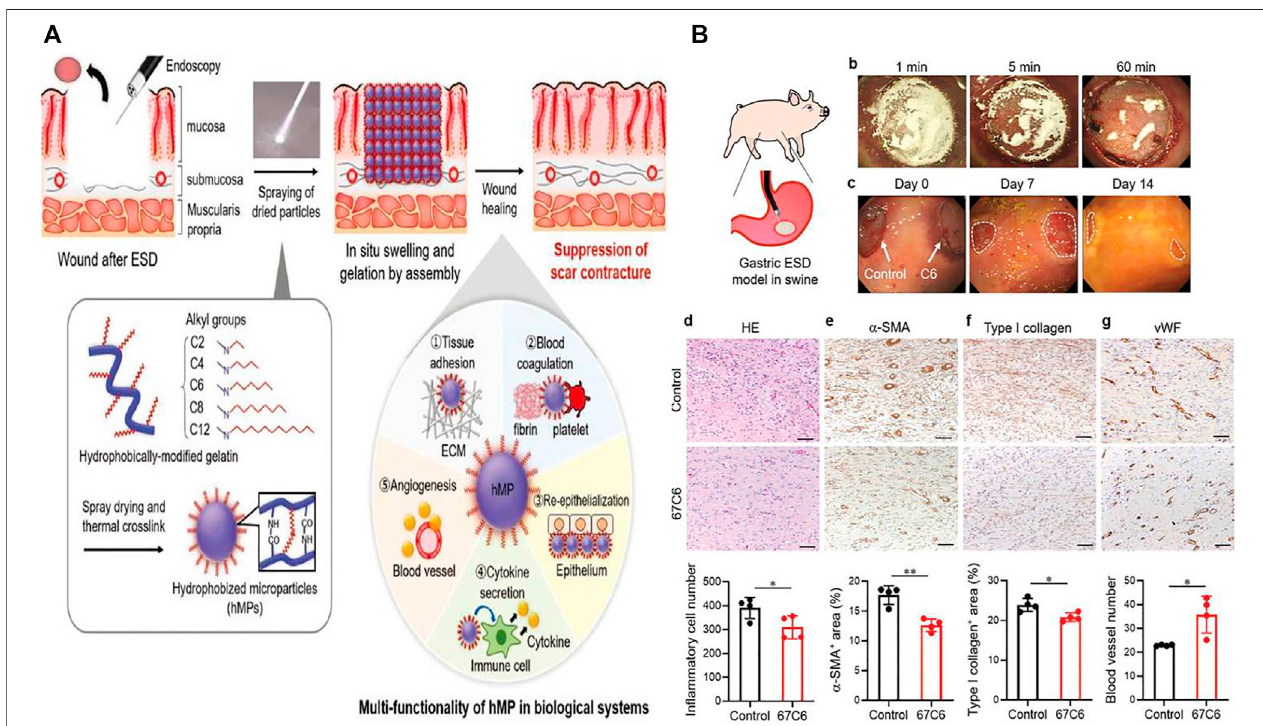
FIGURE 6 | The preparation and application of colloidal wound dressings to facilitate ulcer healing after ESD. (A) The schematic diagram of multifunctional hydrophobic colloidal dressings for wound repair. (B) Hydrophobic colloidal dressings effectively suppressed wound fi brosis after ESD in the swine stomach model. Reproduced from Nishiguchi et al. (2019). Copyright (2019), with permission from John Wiley and Sons.